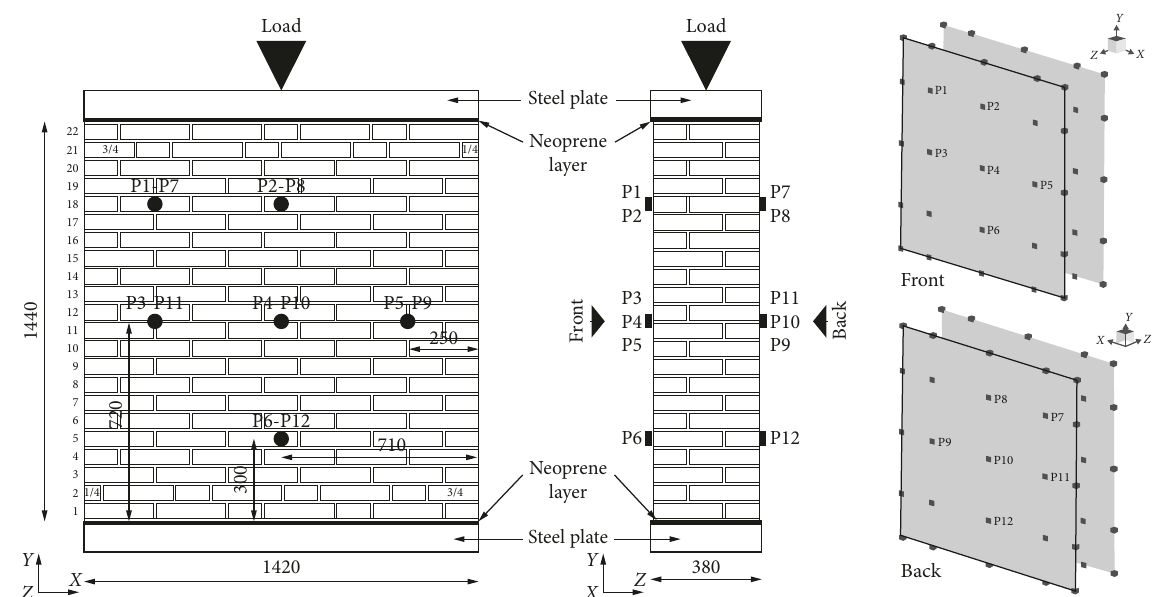
Figure 4: Scheme of the test setup (dimension in millimeters).